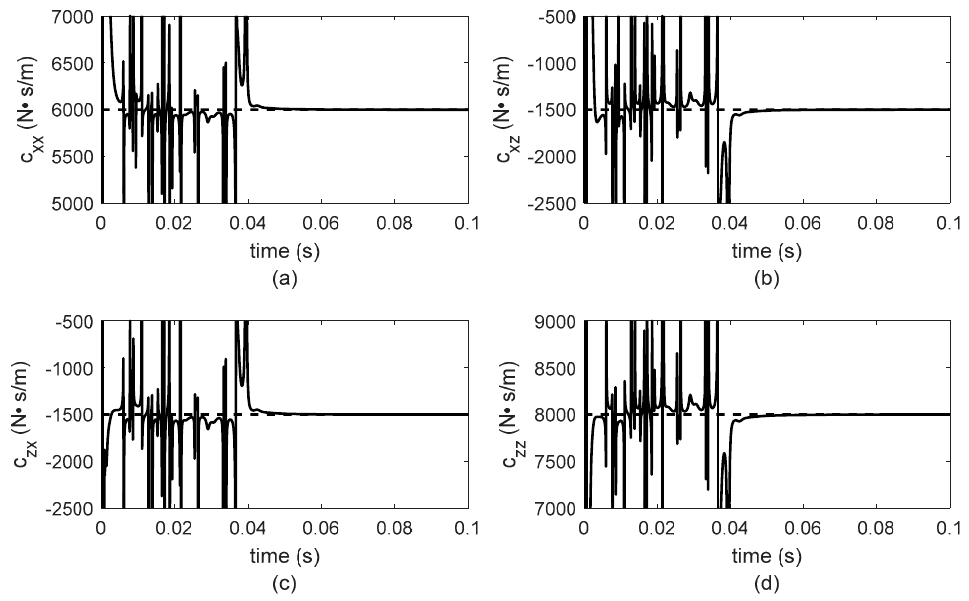
Figure 13. Identified damping parameters for bearing 2 with a linear ramp of excitation of 10 rad / s 2 . ( a ) c xx , ( b ) c xz , ( c ) c zx , ( d ) c zz